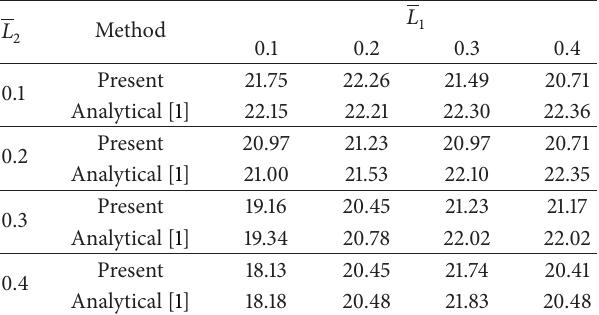
Table 3: Dimensionless fundamental frequencies of the I:C-C beam with a central and midplane delamination.